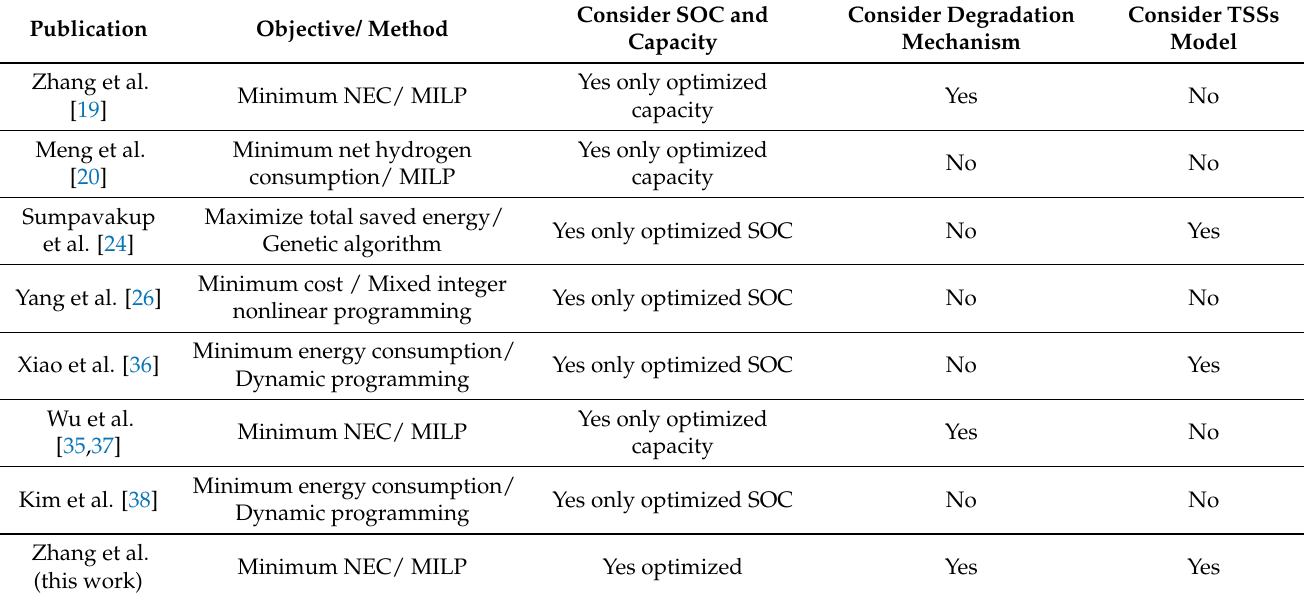
Table 1. Summary of the relevant studies on the modeling